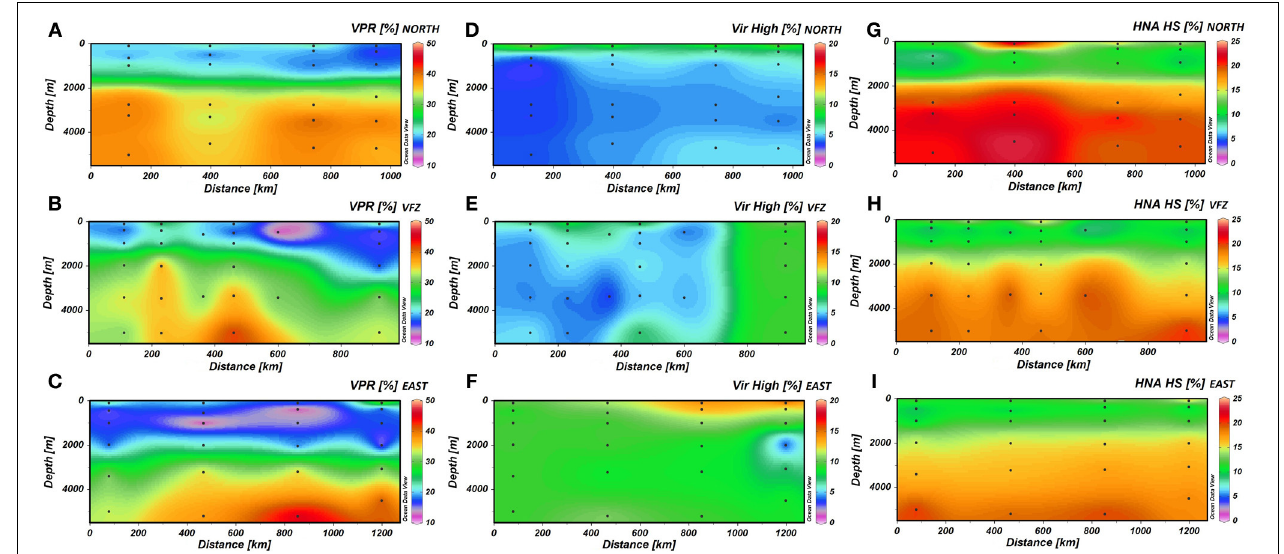
FIGURE 2 | The spatial distribution of the virus-to-prokaryote ratio (A–C) and the high fluorescence nucleic acid containing viral (D–F), and prokaryotic (G–I) cells north (upper panels), within (center panels) and east (lower panels) of the Vema Fracture Zone of the subtropical North